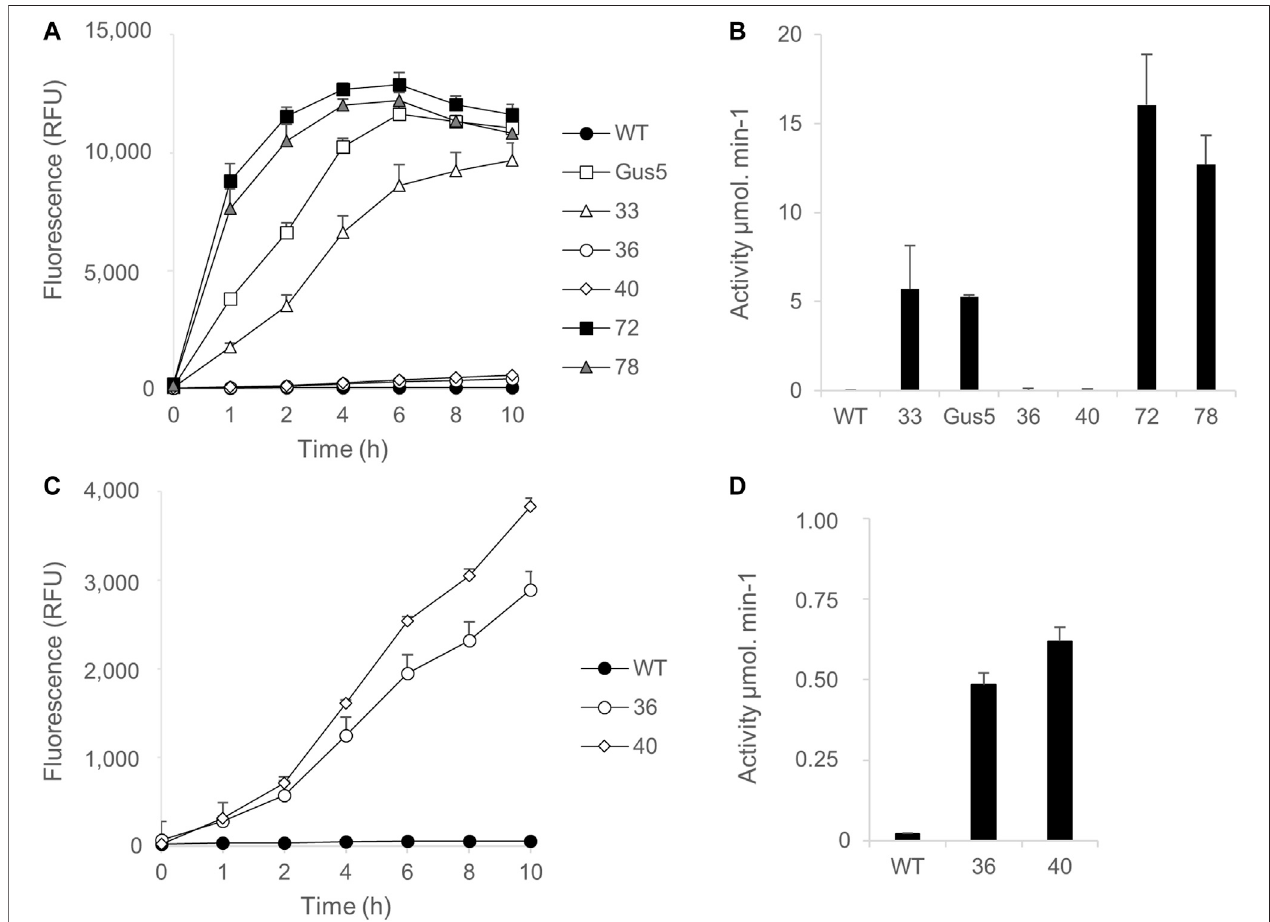
FIGURE5| Quanti fi cationof β -glucuronidaseactivityinsingle-copytransgeneclones(CLOSITRA)usingsynthetic fl uorogenicsubstrates. (A) Fluorescence[relative Fluorescence Unit(RFU)] measured inall clones harboring anintact single-copytransgene using 1 µM ofthesubstrate MUG. β -glucuronidaseactivity wasmeasured by theaccumulationofthe fl uorogenicglucuronidaseproduct4-methylumbelliferone(4-MU)andisrepresented asrelative fl uorescenceunits(RFU)onthe y -axis.WTlysate was included as a negative control and Gus5 as the reference strain and positive control. Data points represent the average of triplicate technical measurements. Errorbarsrepresentstandarddeviation(SD)ofthemeansoftwoindependentexperiments. (B) Glucuronidaseactivity(µmol.min − 1 )wasmeasuredafter1 hofincubation inthepresenceof1 µMofthesubstrateMUG. (C) Fluorescence[relativeFluorescenceUnit(RFU)]measuredforclones36and40using10 µMofthesubstrateMUG.( D ) Glucuronidase activity (µmol.min − 1 ) was measured after 4 h of incubation in presence of 10 µM of the substrate MUG.